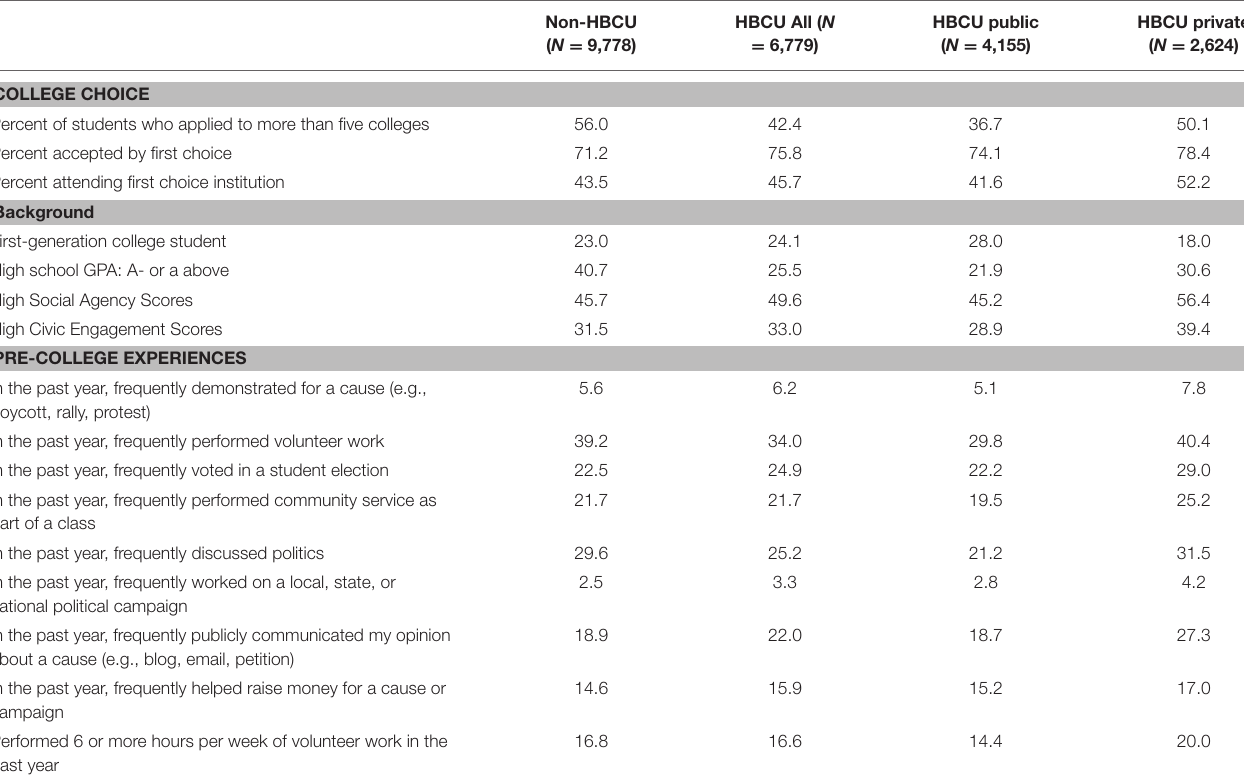
TABLE 1 | Incoming first-year African American student’s background characteristics and pre-college